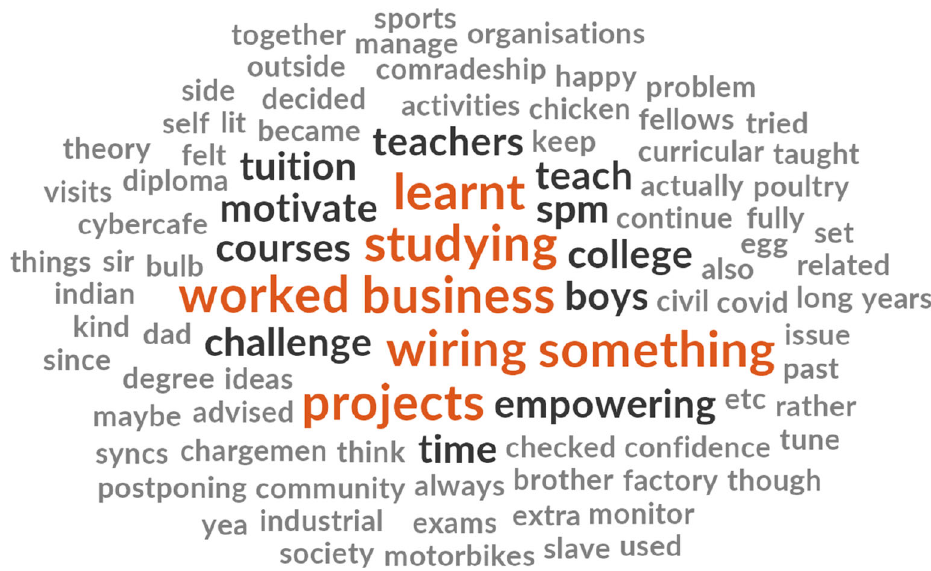
Figure 3. Word cloud diagram illustrating the key interests of the B40